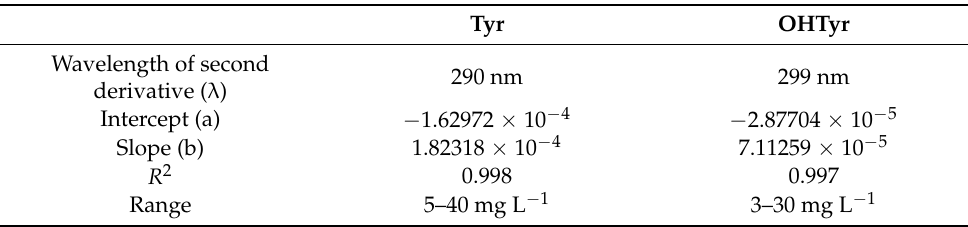
Table 1. Parameters of the calibration curves of OHTyr and Tyr in NADES.